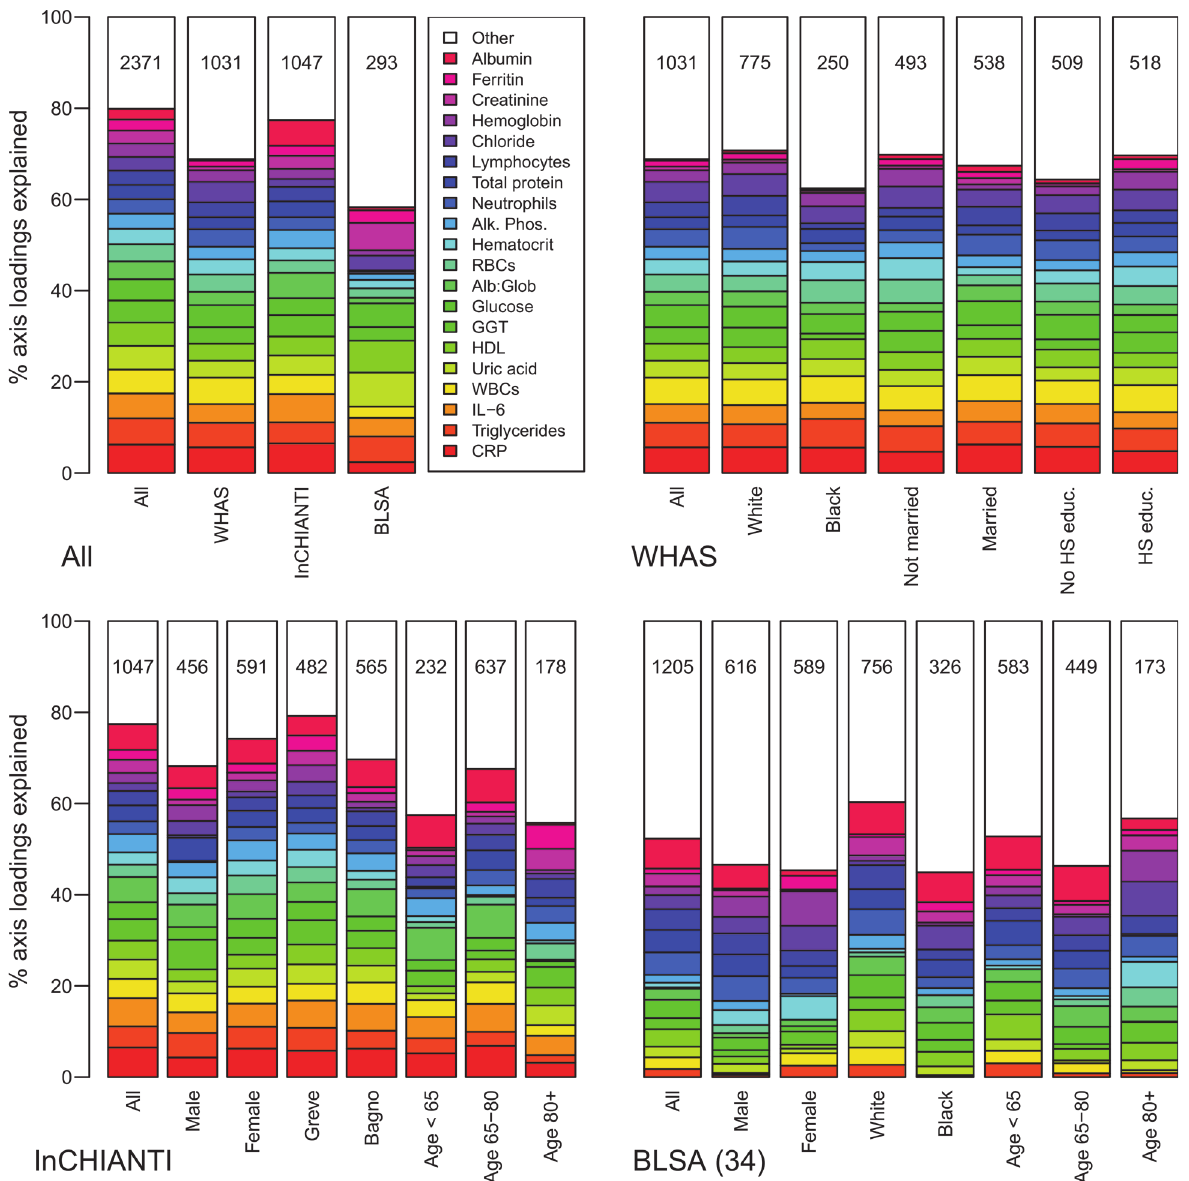
Fig 2. Biomarker loading order and stability for PCA2 across data sets and subsets. Loading importance is calculated as the loading divided by the sum of the absolute values of all loadings. These values are ordered from high (red, on bottom) to low (magenta, on top) for the first 20 loadings; remaining loadings are grouped together as “ Other ” in white. Accordingly, CRP has the strongest loading, then triglycerides, then IL-6, etc. The order and colors are derived from the full analysis combining the three data sets (left column, top-left panel “ All ” ) and applied to all other columns in the figure. Stability of loadings is indicated by conservation of loading heights across bars. For each panel, the loadings for the full data set are at left. Numbers indicate subset sample sizes. For all panels except BLSA, the 43-variable set is used; for BLSA there was insufficient sample size to perform PCA on subsets with 43 variables, so the 34-variable analysis is presented. The poor performance of BLSA is because several of the key variables in PCA2 are missing in the 34-variable